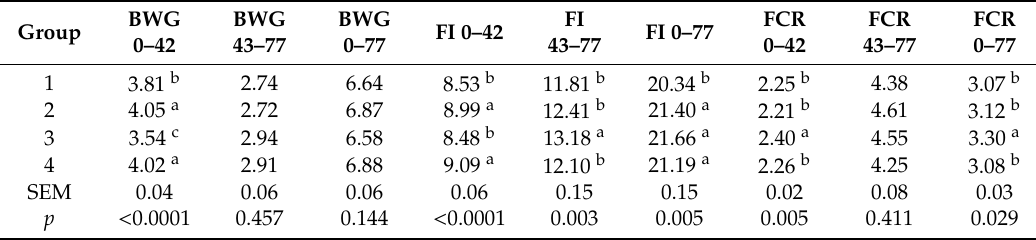
Table 4. Productivity paramters of geese during the rearing